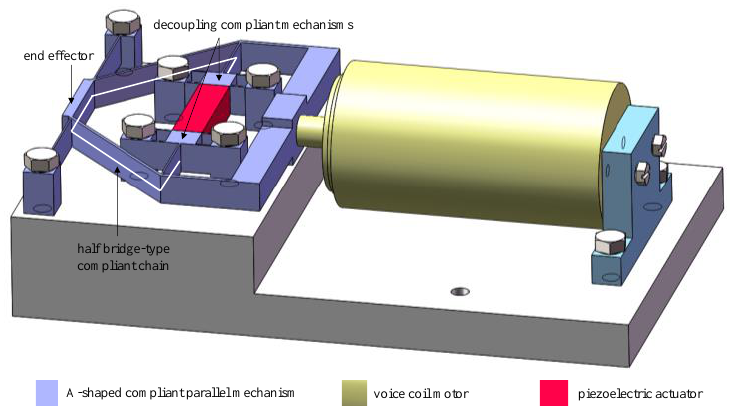
Figure 1. Structure of the PDCNS.